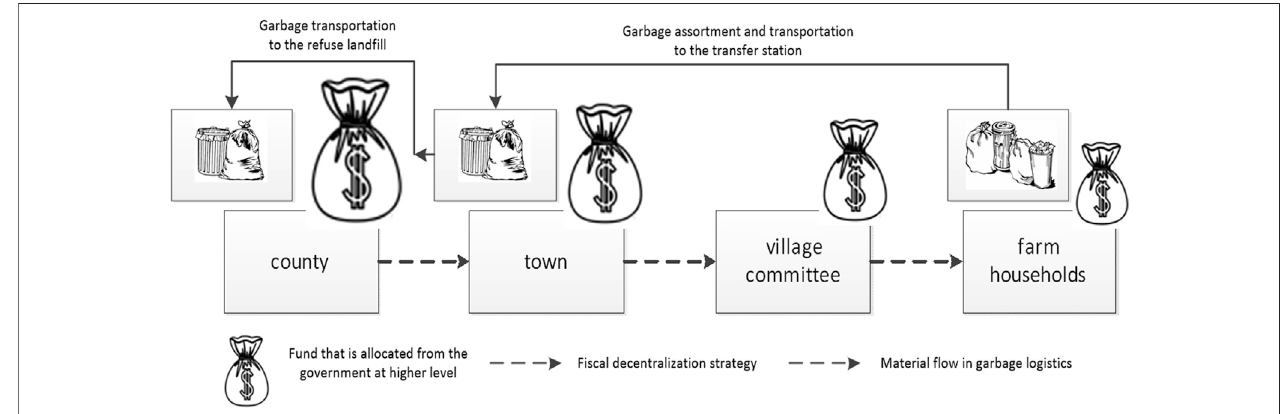
FIGURE 1 | The procedures of garbage processing and fi nal decentralization. Notes: The above fi gure takes one village as an example. Otherwise, the amount of garbage transported to the land fi ll (i.e., from right to left) would cumulatively increase.